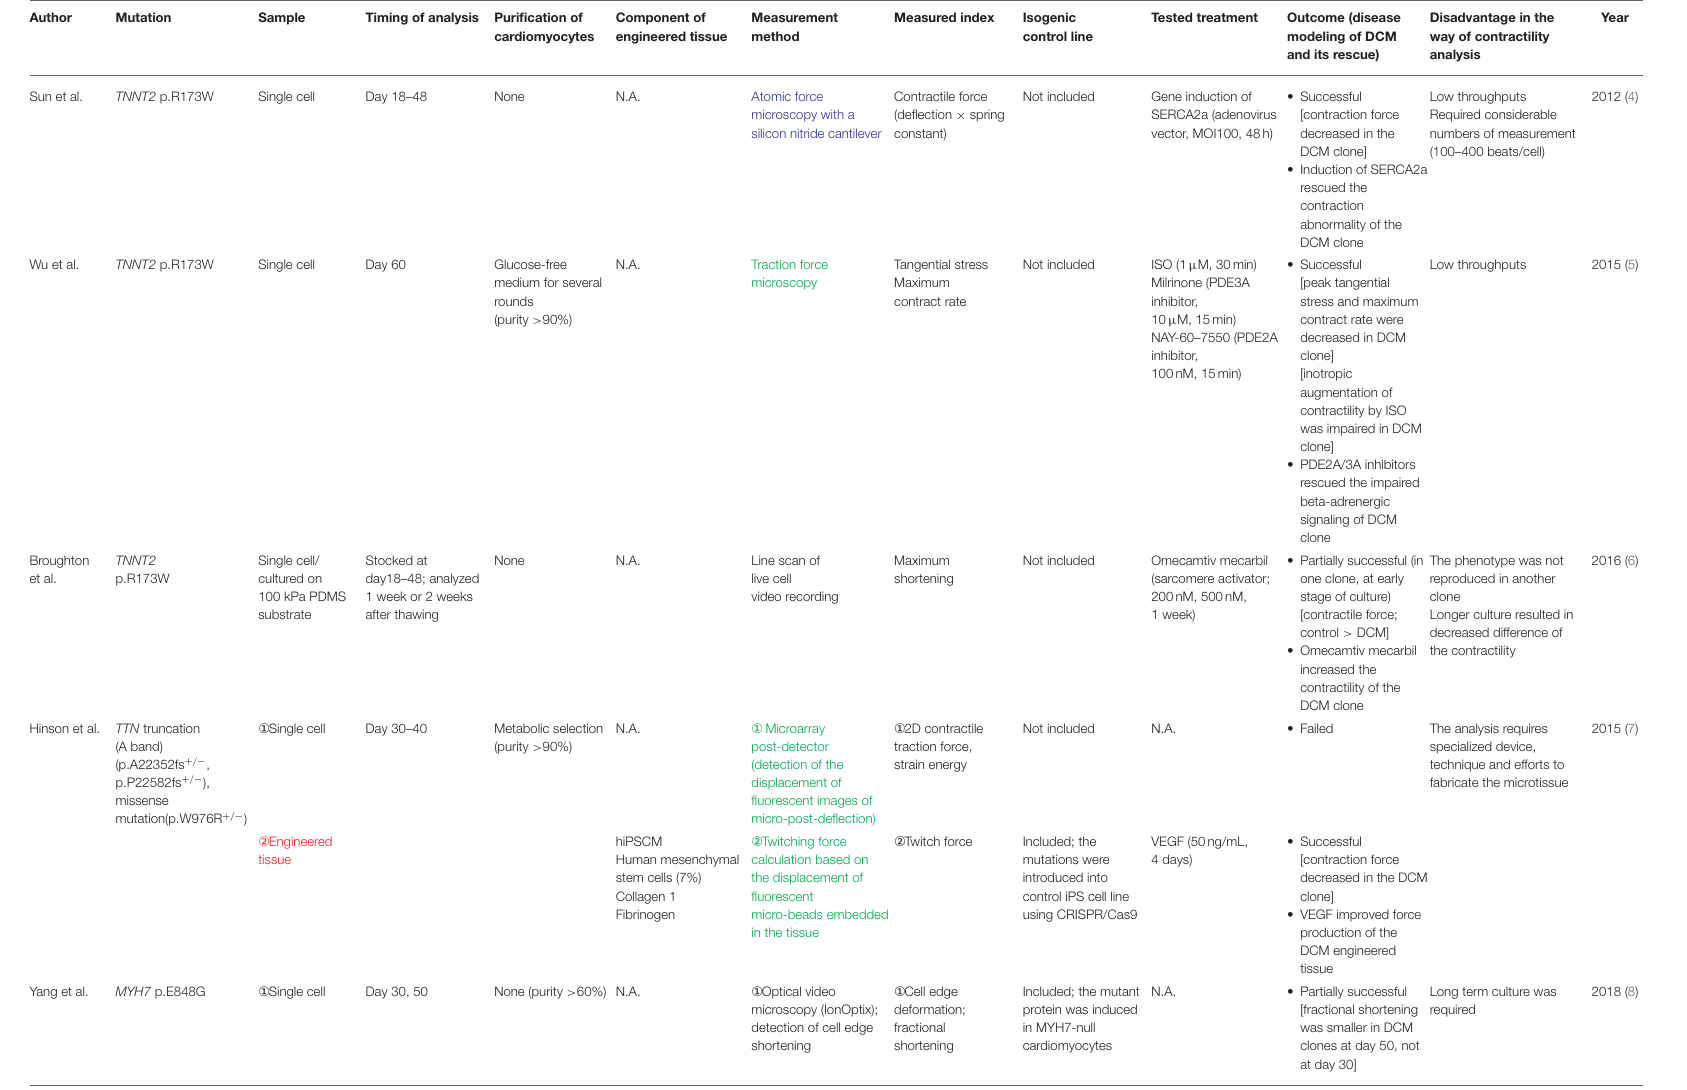
TABLE 1 | Overview of the studies analyzing contractile properties of hiPSCMs from DCM